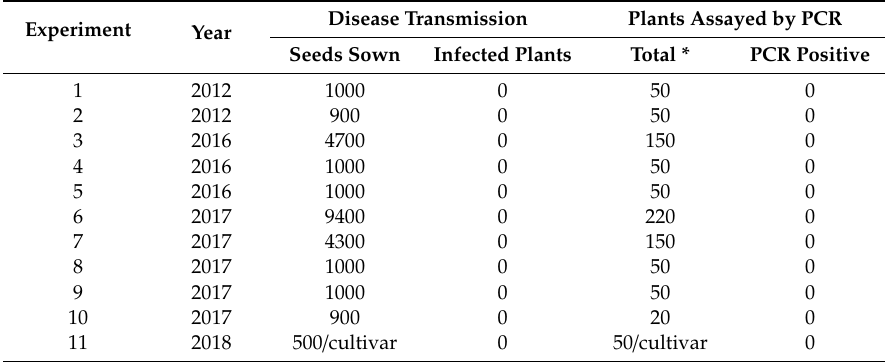
Table 3. Seed transmission of downy mildew caused by Peronospora belbahrii in basil plants. Disease Transmission Plants Assayed by PCR Experiment Year Seeds Sown Infected Plants Total * PCR